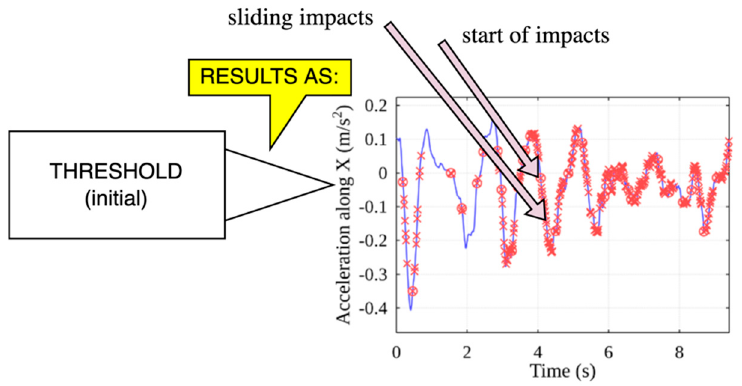
Figure 5. Initial threshold detection process deconstruction with main and sliding impacts.